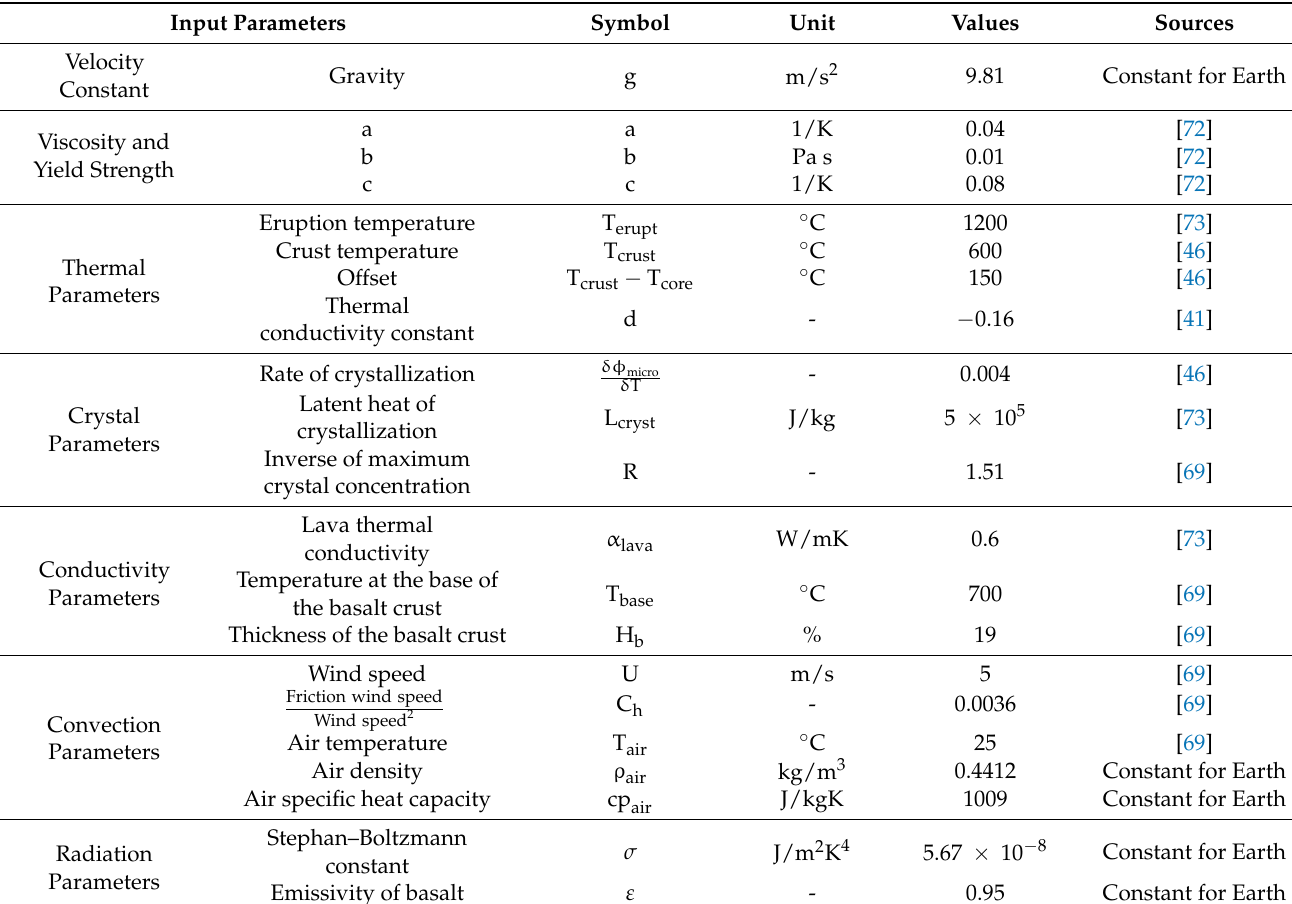
Table 1. Parameters used for the Q-LavHA simulation using the L flowgo